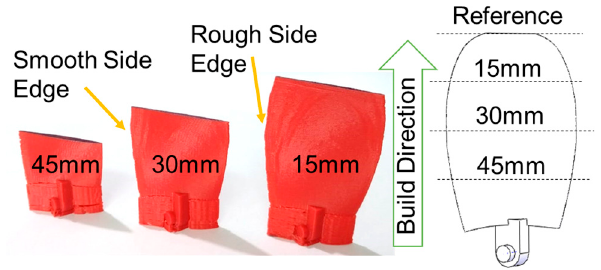
Figure 7. Manufactured truncated models and reference from the CAD model. The arrows show the quality of side edges of the 3D printed impellers. Table 2. The measurements values of CAD and physical models.